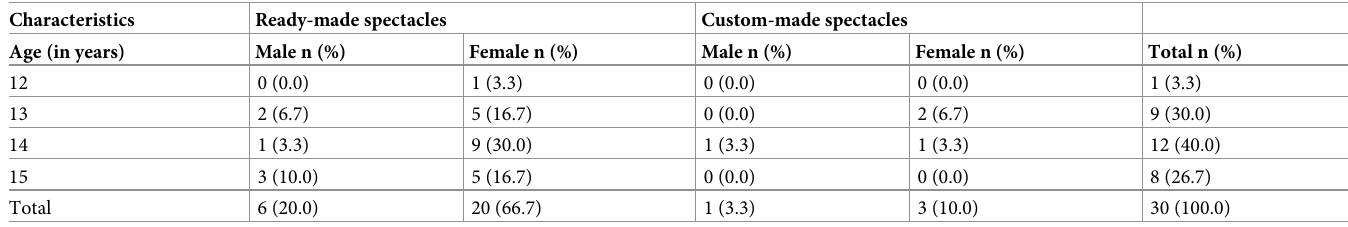
Table 3. Distribution of ready-made and custom-made spectacles.